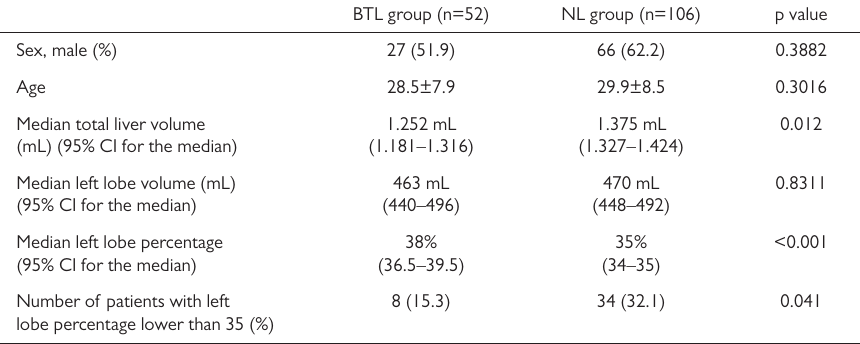
Table 1. Study and demographic data of the study groups with corresponding p values BTL group